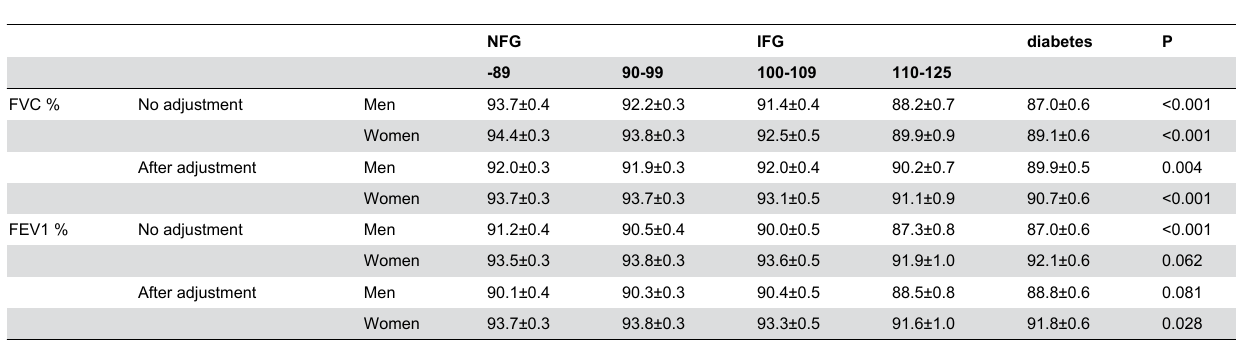
Table 2. Predicted FEV1 % and predicted FVC % by fasting plasma glucose.